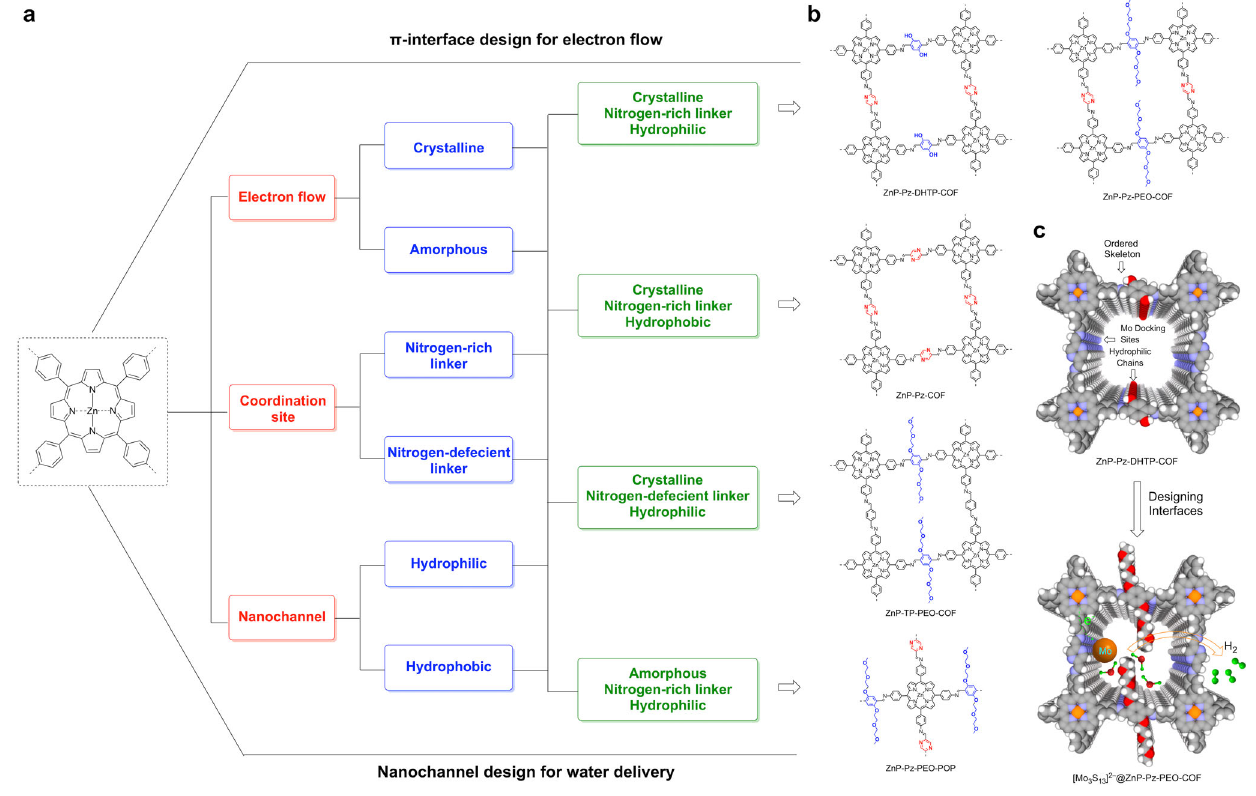
Fig. 1 | Integrated interfacial designs of photocatalysts. a The integrated inter- facial design strategy for constructing π skeleton, wall and pore to merge three different interfaces, i.e., electron fl ow, active site ligating and water transport, into the photocatalysts to promote photocatalytic H 2 production from